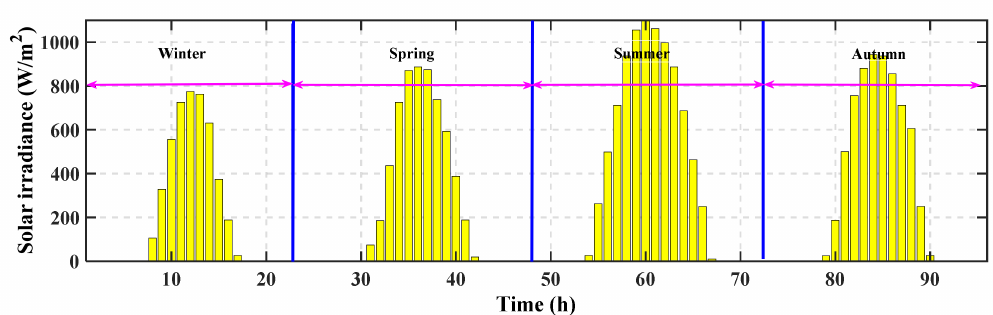
Figure 4. The solar irradiance variations.